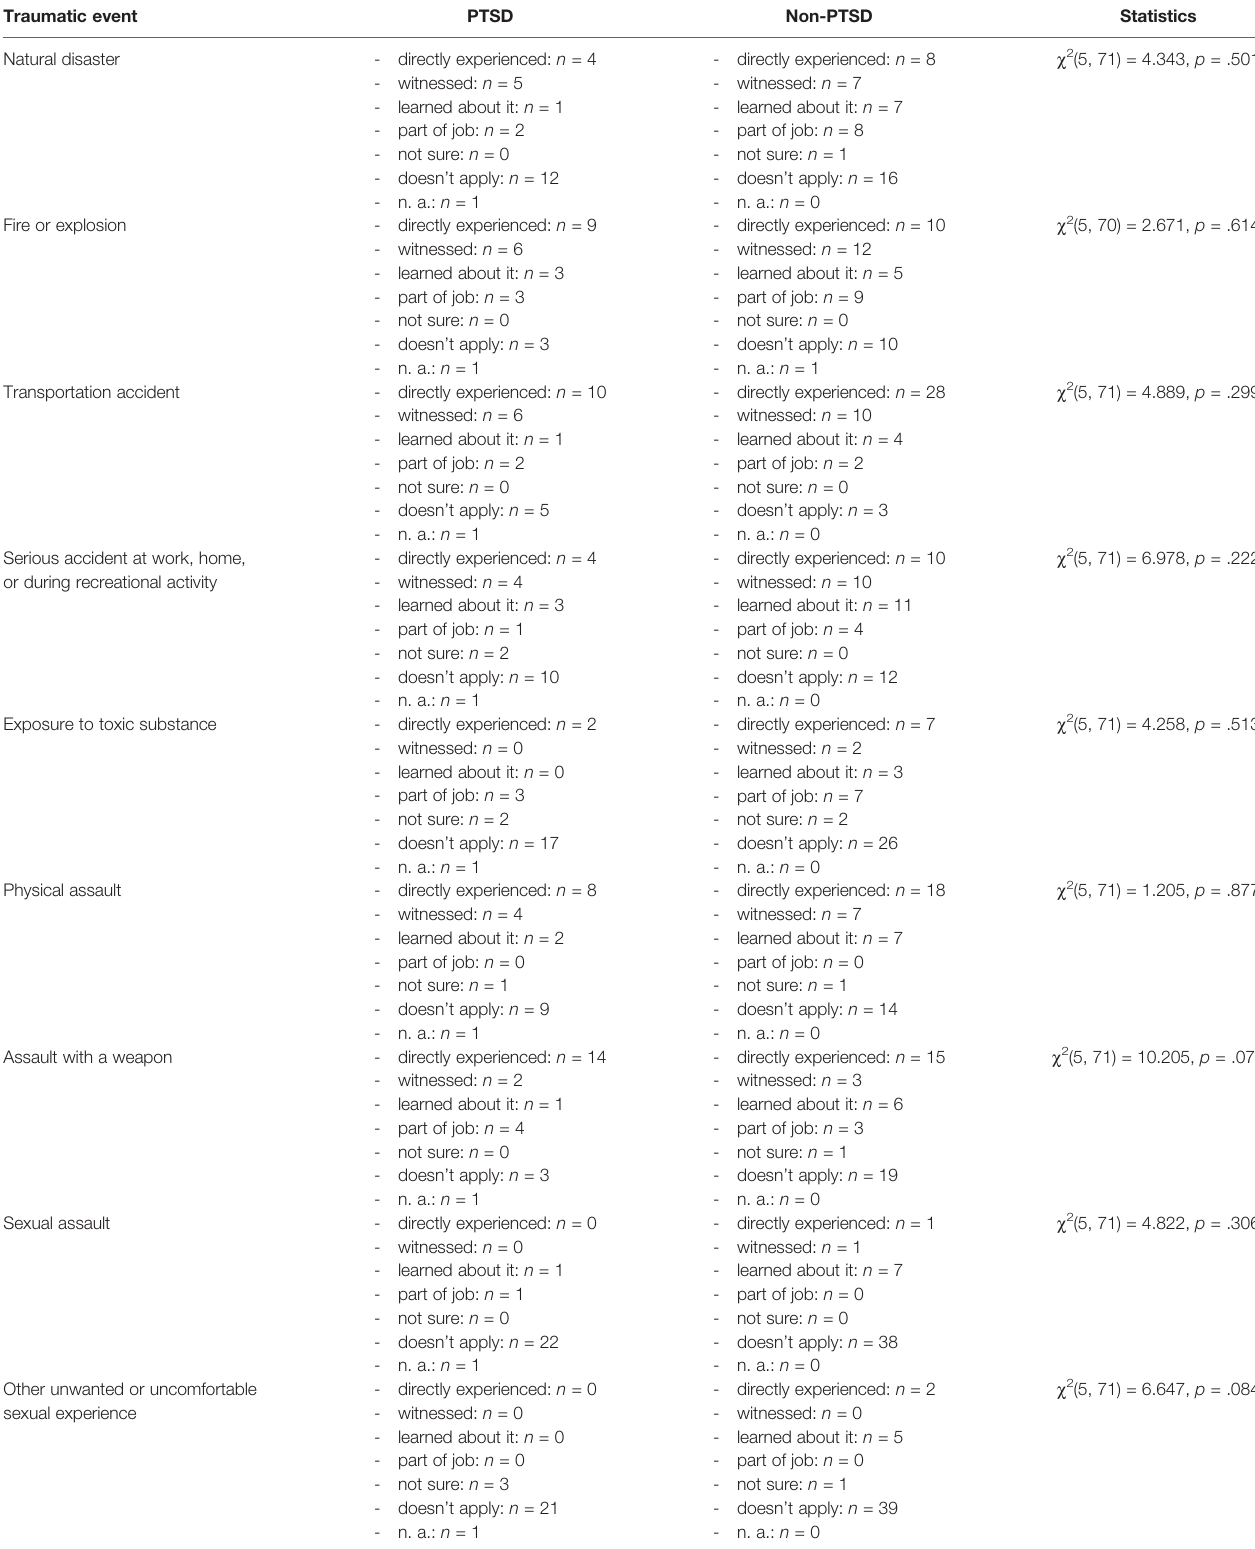
TABLE 3 | Frequencies of traumatic events according to the Life Events Checklist for DSM-5 for GAF service members with and without PTSD. Traumatic